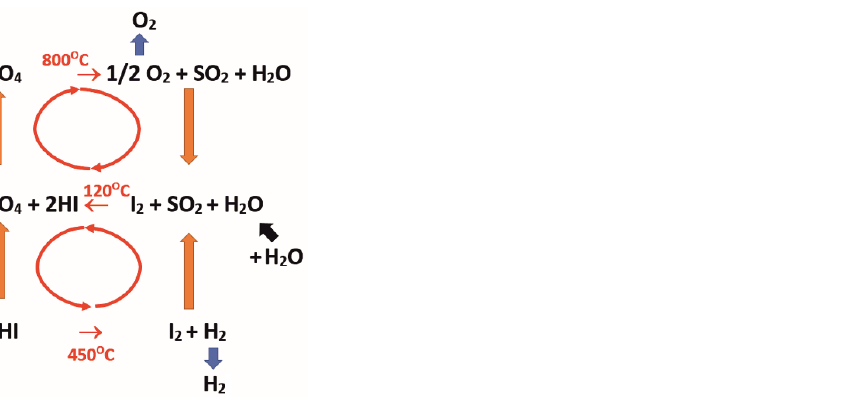
Figure 4. Diagram of the sulphur-iodine cycle (S-I). Source: Author’s own